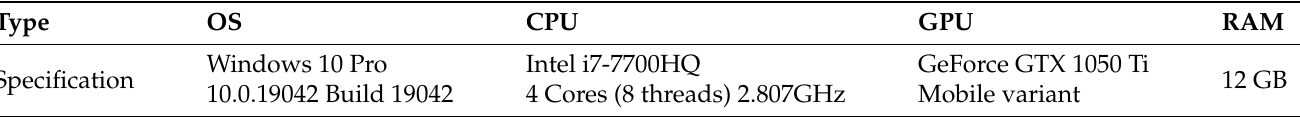
Table 4. Notebook specification used in this